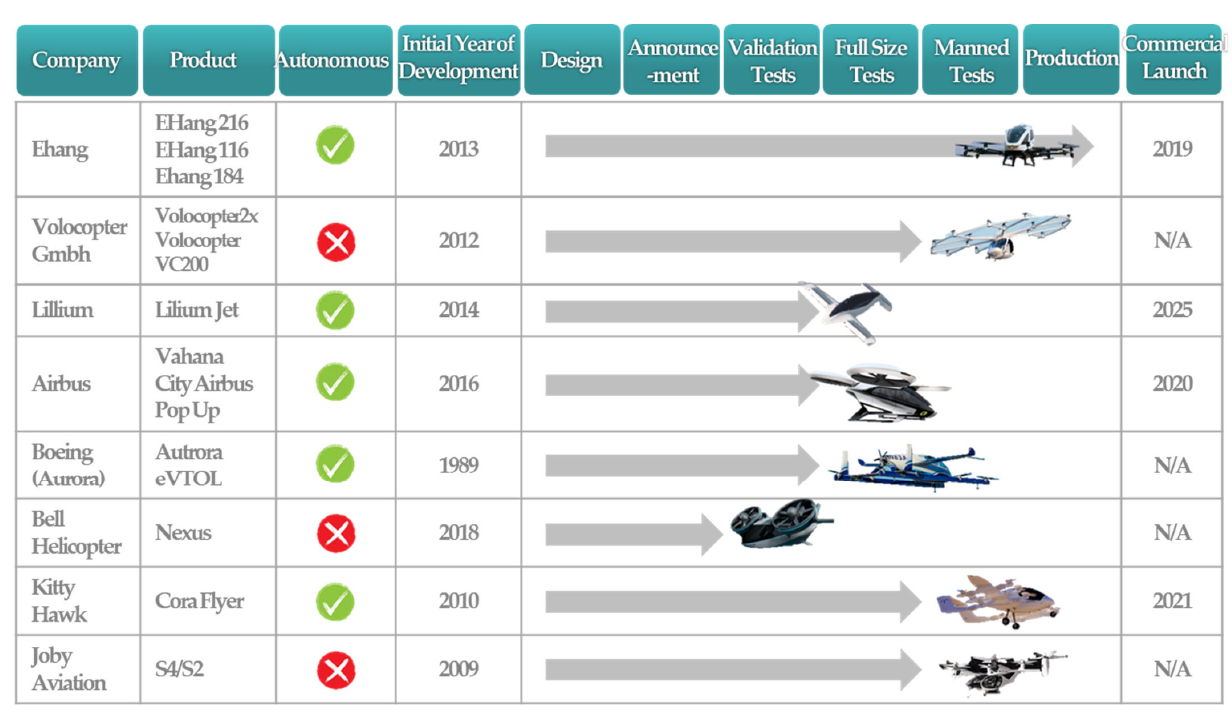
Figure A1. eVTOL production schedule.